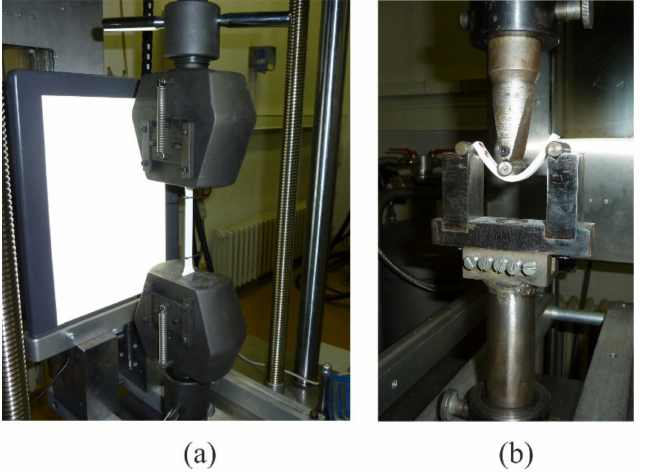
Figure 3. Jaws for tensile and flexural testing: ( a ) jaws for tensile testing, ( b ) supports for flexural